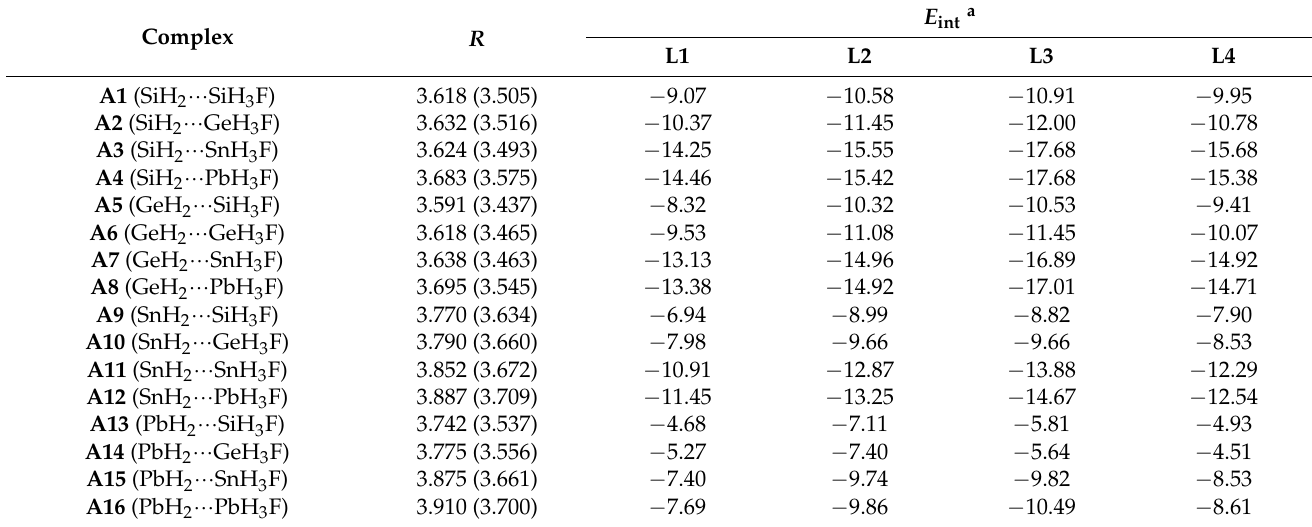
Table 1. Binding distance at MP2/aug-cc-pVDZ and MP2/aug-cc-pVTZ (in parentheses) levels ( R ,